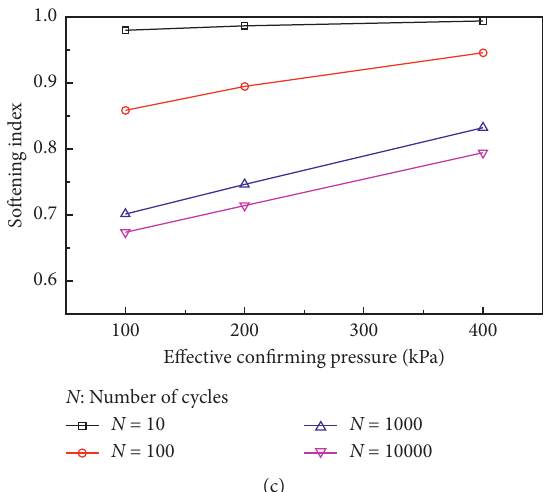
Figure 10: Curve of effective confirming pressures and softening index under different number of cycles: (a) P � 20%and U � 0 . 80; (b) P � 20% and U � 0 . 90; (c) P � 20% and U � 0 . 98.